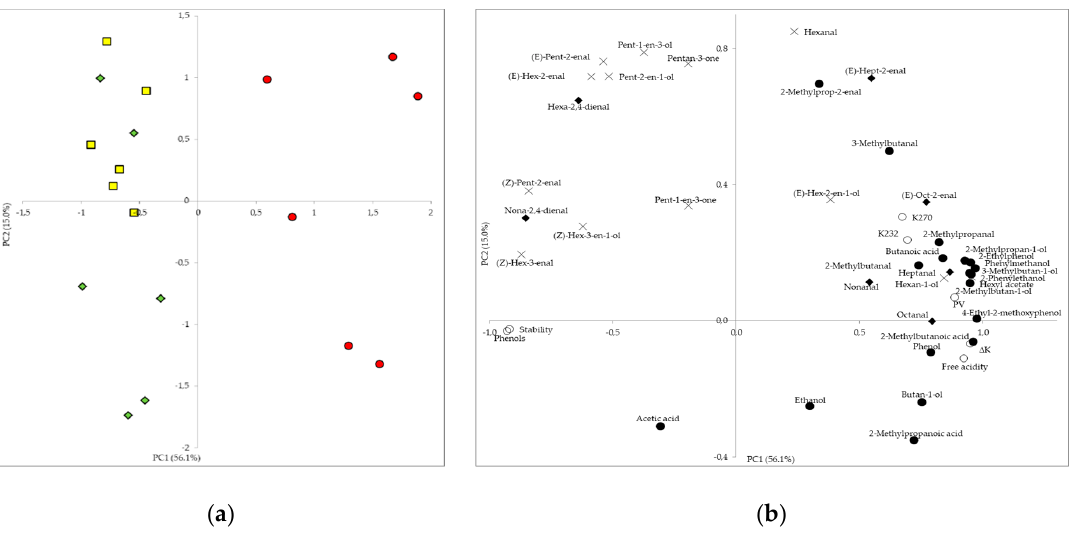
Figure 2. Projection of the oil samples ( a ) and variables from tables 1, 3, 4 and 5 ( b ) onto the space defined by the first two principal components (PC1/PC2). : Organic; Conventional; Ground. ο : Chemical and physical-chemical parameters; × : LOX-derived volatile compounds; • : Fermentation compounds; ♦ Oxidation compounds.